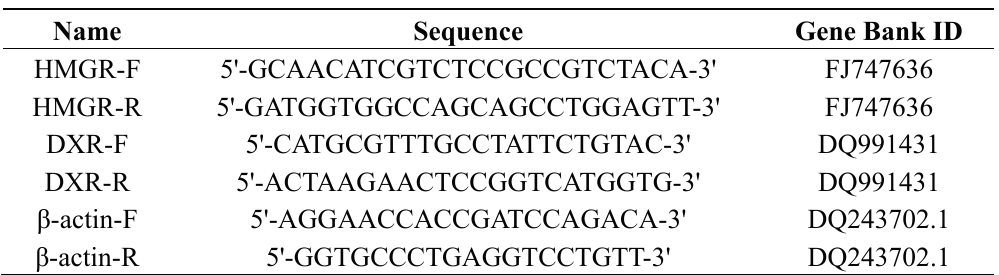
Table 1. The primers of genes in